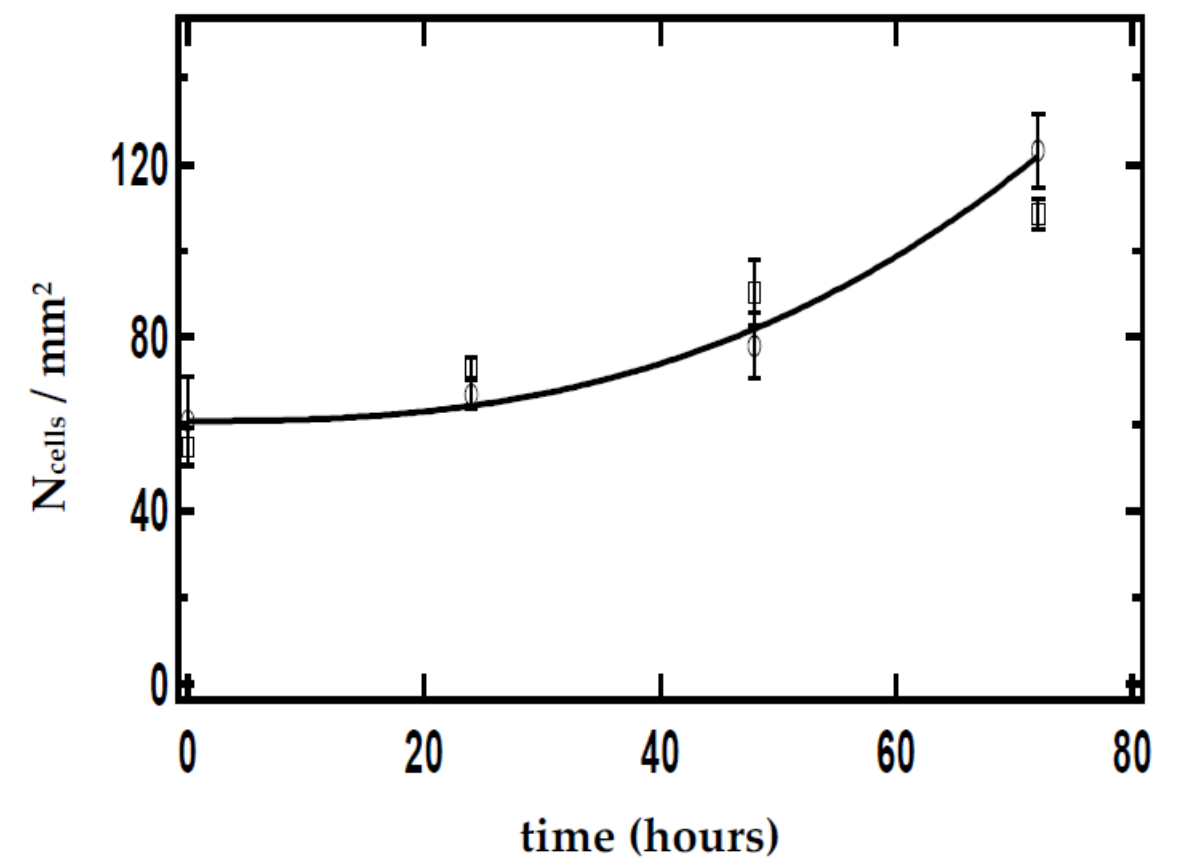
Figure 7. The squares and circles represent the dependence of normal fibroblast cell density fed with normal media and media mixed with CaS clusters, respectively. The time t = 0 h is taken to correspond to the time of the initial dose. The solid line is to guide the eyes through the discussion and does not represent a model fit. The spectrum of the CaS nanocluster dispersion employed is indicated in the insert. The total number of mol of Ca 2+ in the dispersion is 4 × 10 − 8 .